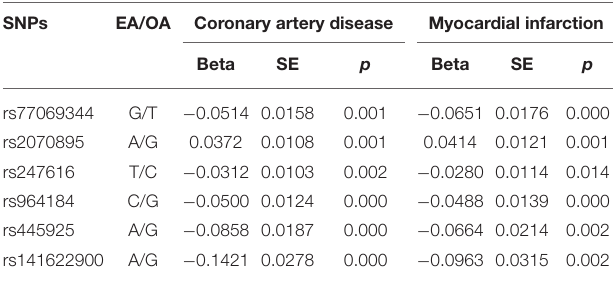
TABLE 3 | Genetic association of cholesterol efflux capacity related genetic variants with coronary artery disease and myocardial infarction in the CARDIoGRAMplusC4D